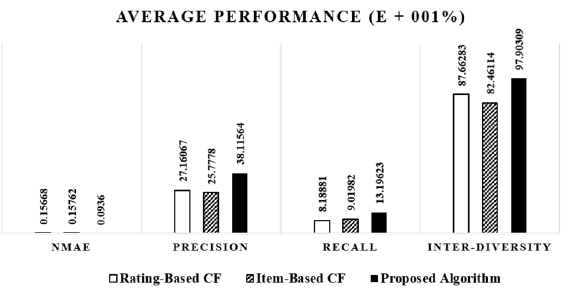
Figure 6. The average performance of the proposed algorithm in comparison with item-based collaborative filtering (CF) and rating-based CF.